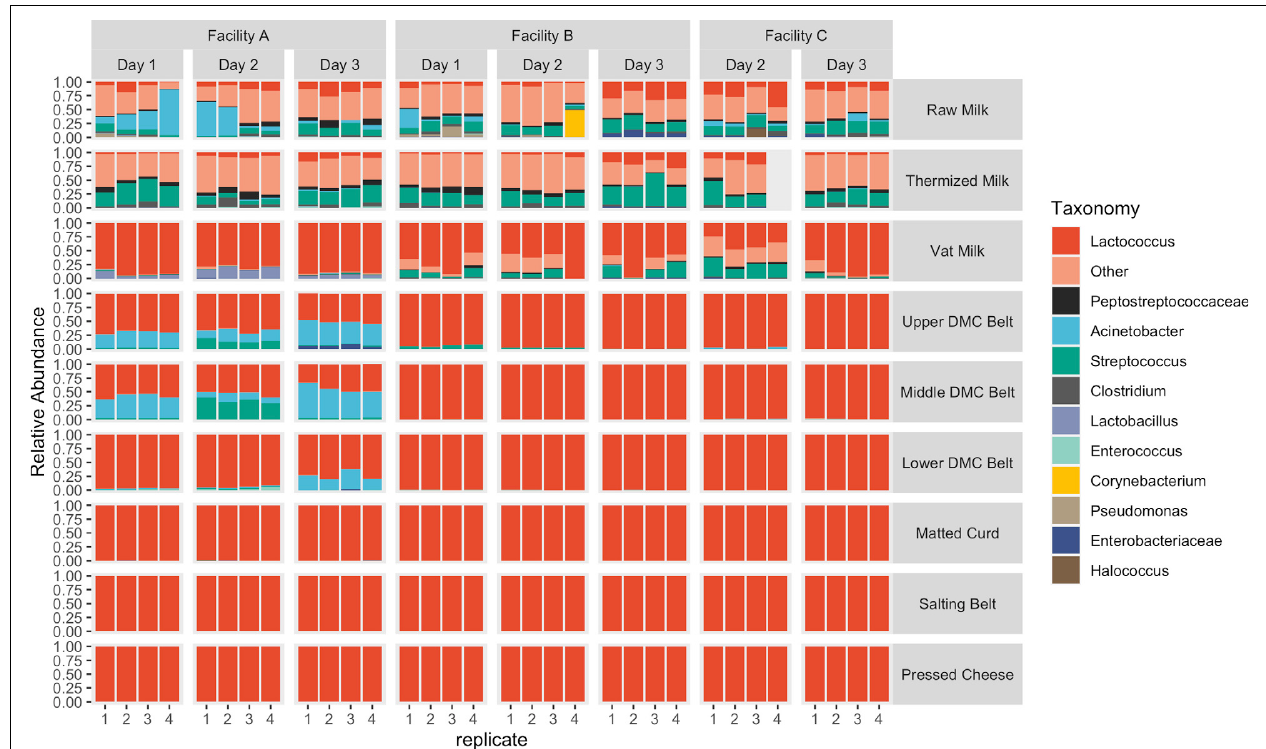
FIGURE 7 | Relative abundance of taxonomic features separated by sample location. Features with a relative abundance > 10% in the milk samples and > 1% in the remaining locations were grouped as “Other.”